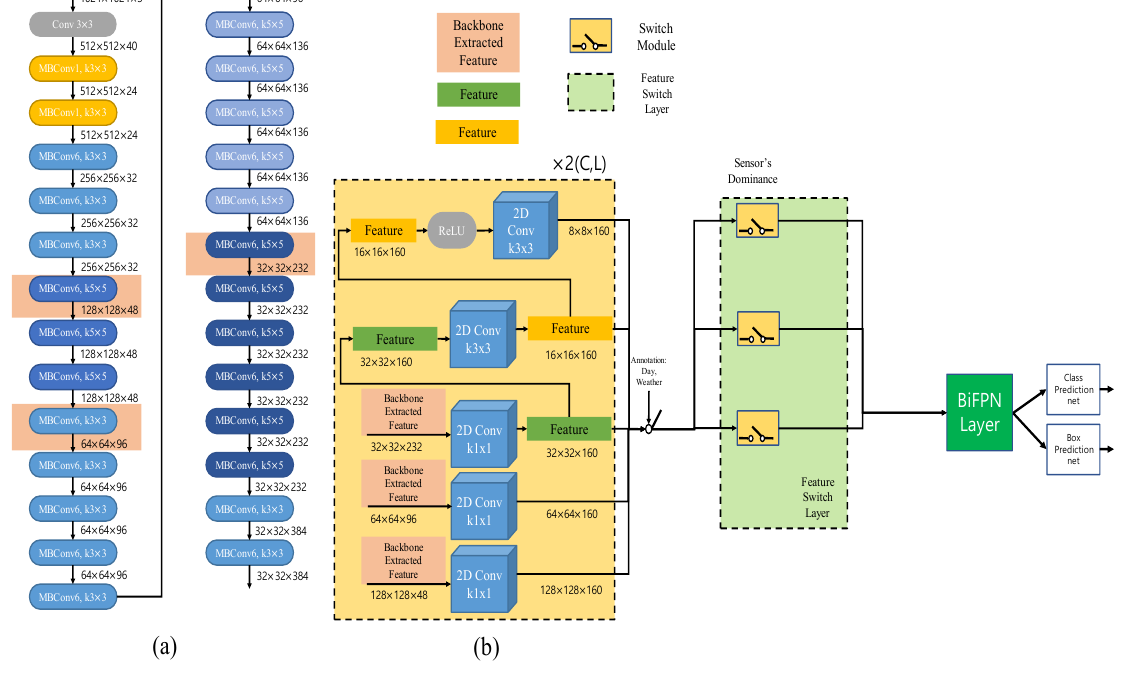
Figure 4. ( a ) Illustration of the EffecientNet-B3 architecture. We used backbone with EfficientNet- B3. ( b ) Input of switch module. C stands for camera backbone operation and L stands for LiDAR backbone operation, and each conv block of the same size is used.